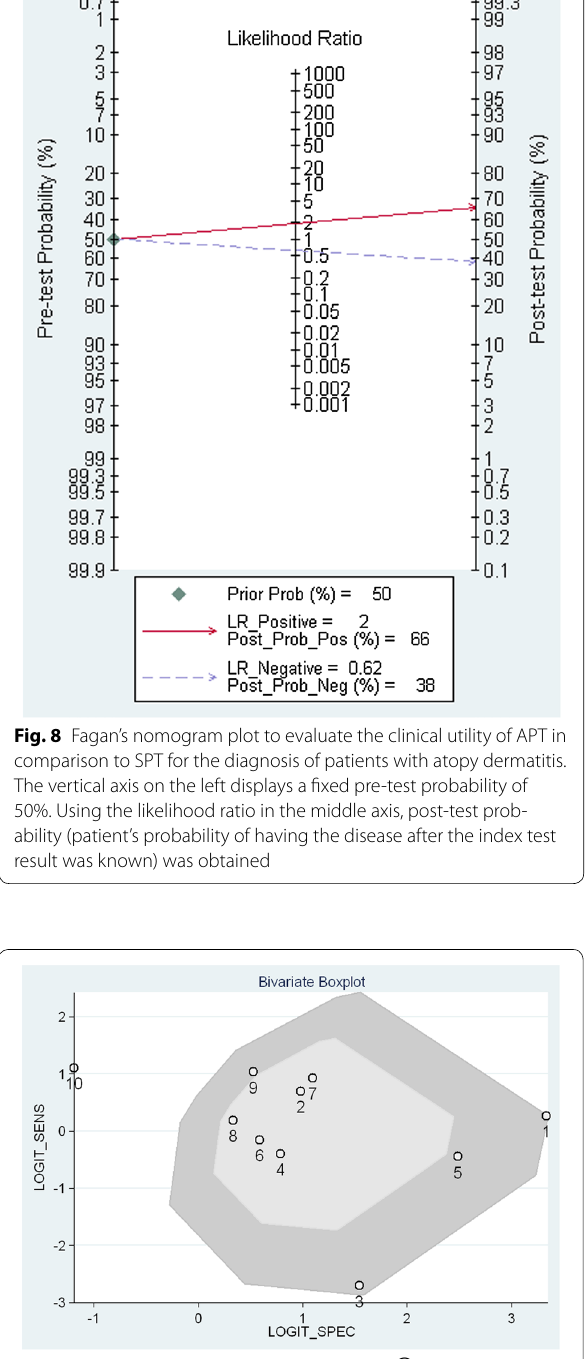
Fig. 9 Bivariate box plot for evaluating outliers. ① Heinemann et al.; ② Wistokat-Wülfing et al.; ③ Lorenzini et al.; ④ Darsow et al.; ⑤ Kutlu et al.; ⑥ Manzini et al.; ⑦ Wananukul et al.; ⑧ Michel et al.; ⑨ Holm et al.; ⑩ Fuiano et